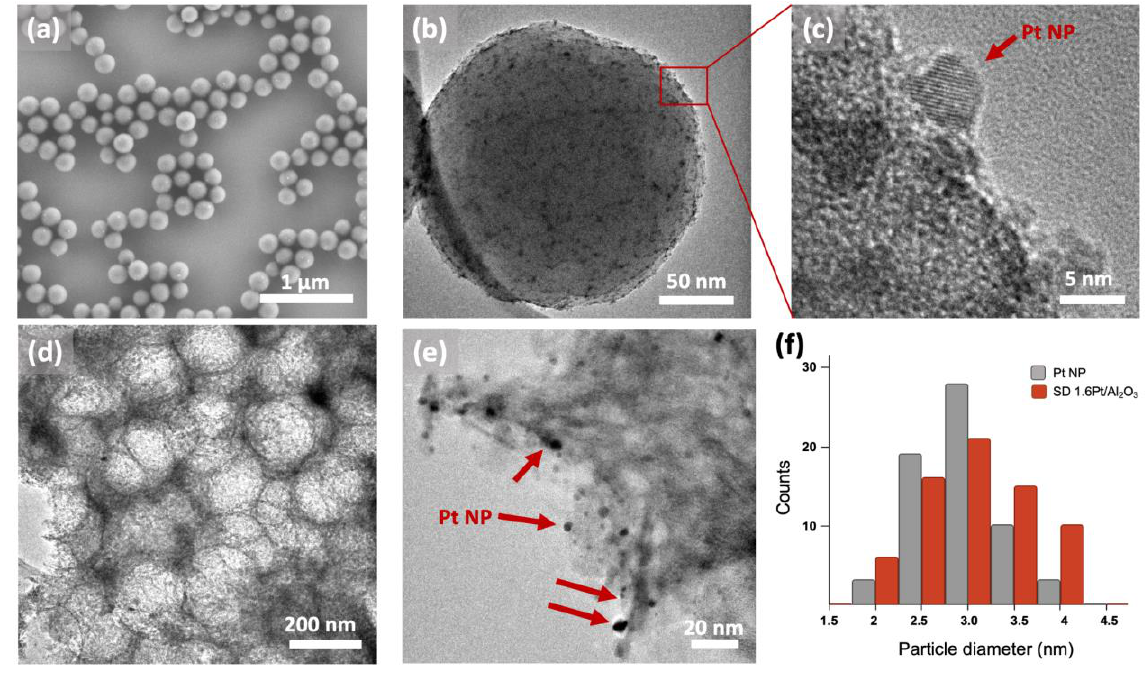
Figure 2. Representative scanning and transmission electron microscopy (SEM and TEM) images of material building blocks and resulting SD 1.6Pt/Al 2 O 3 powders synthesized using 1.6Pt@PS raspberry colloids. ( a ) SEM and TEM ( b , c ) images of 1.6Pt@PS raspberry colloidal particles with ( c ) showing a high magnification TEM image of ( b ) in which the Pt NPs attached to the surface of PS colloid are more clearly visible. ( d , e ) Representative TEM images of SD 1.6Pt/Al 2 O 3 catalyst powders with ( e ) showing a higher resolution image where Pt NPs are visible at the pore-matrix interface. ( f ) Histogram of the measured NP size distribution for as-prepared Pt NPs (gray) and those within the RCT SD Pt/Al 2 O 3 powder catalyst after calcination at 500 ◦ C (red), values determined from TEM images using ImageJ. At least 100 NP were analyzed. The diameter of NPs before and after calcination were measured to be 2.8 ± 0.5 nm and 3.2 ± 0.7 nm, respectively, indicating only minor